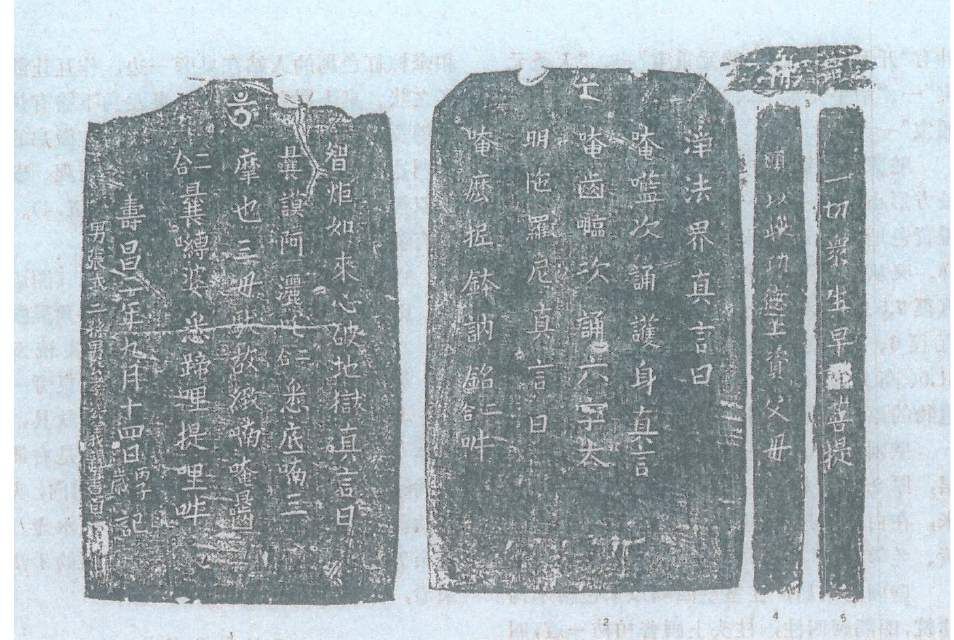
Figure 2. Ink rubbing of a stone stele engraved with Buddhist incantations derived from Collected Essentials on Attaining Buddhahood . Liao dynasty, dated 1096. Excavated from Tomb No. 3 at Wohuwan, Datong City, Shanxi Province of China. After (Datong shi wenwu chenlieguan 1963, p. 433, Figure 3).